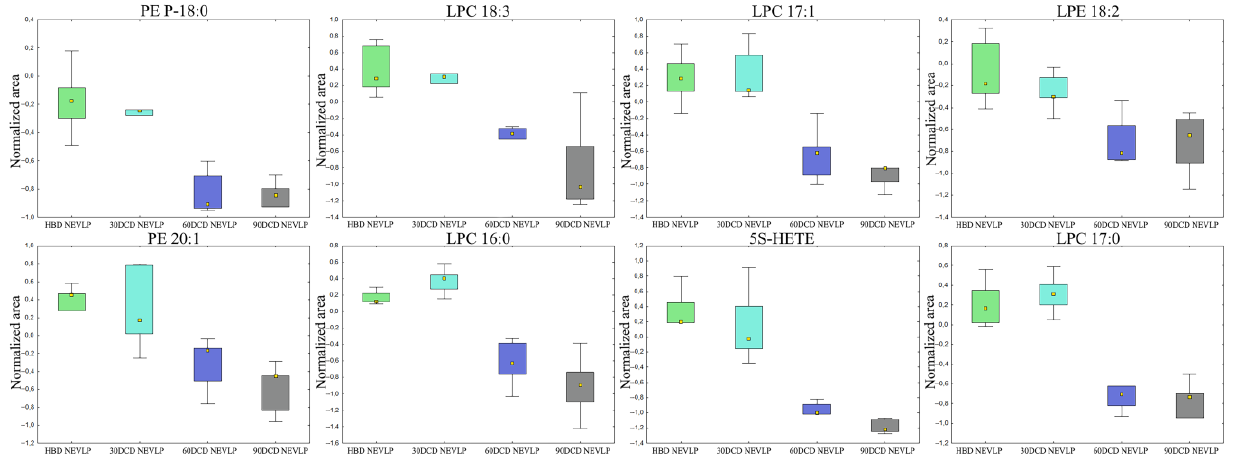
Figure 5. Selected compounds with levels linearly correlated with ischemia time prior to organ harvest. The boxplots show the normalized peak areas, and the height of the rectangles represent the peak areas in the interquartile range (Q1 and Q3). The upper whiskers indicate the largest data point, excluding any outliers, while the lower whiskers indicate the lowest data point, excluding any outliers. The median normalized peak area of each group is indicated with a yellow square.